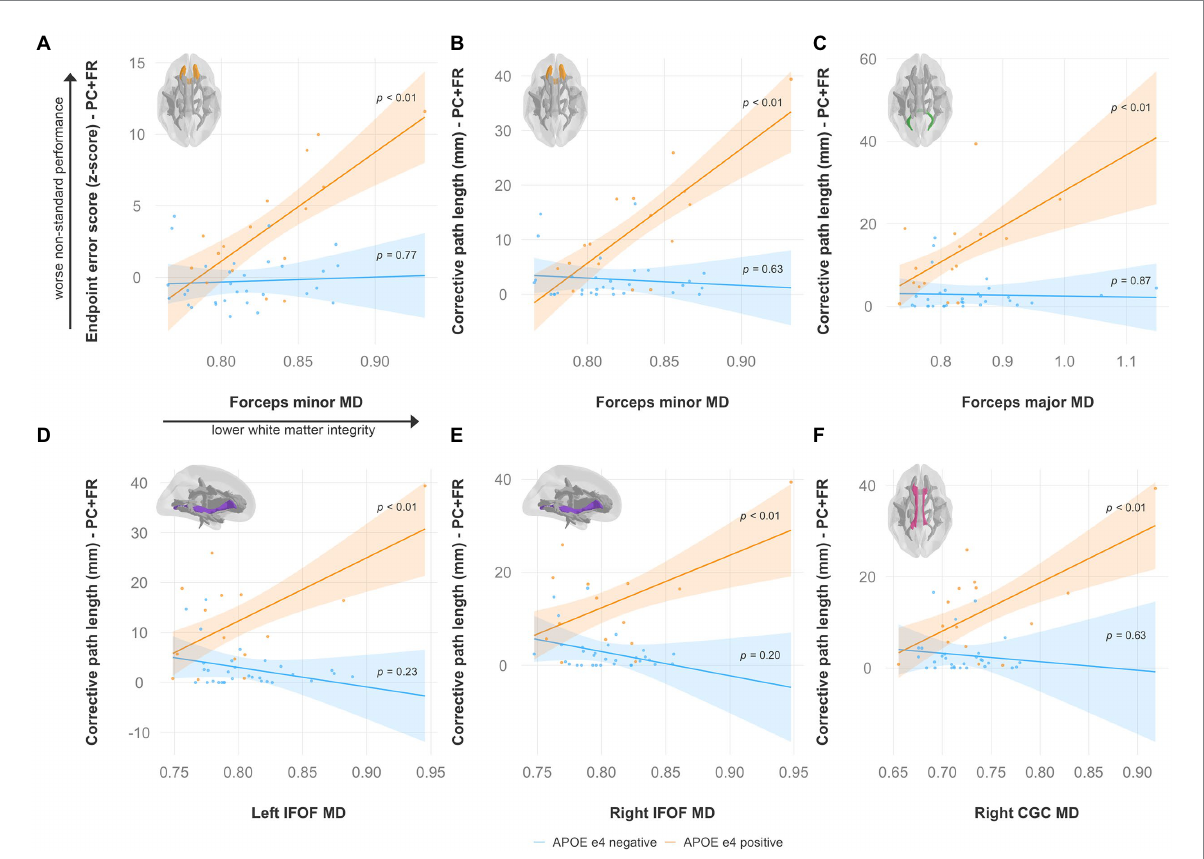
FIGURE 7 Higher mean diffusivity predicts worse visuomotor performance (reflected by higher endpoint error scores or corrective path lengths) in the plane-change feedback reversal condition only in APOE e4 carriers in several major white matter tracts, including the (A,B) forceps minor, (C) forceps major, (D) left IFOF, (E) right IFOF, and (F) right CGC. Significant results shown from multiple regression and simple slopes analyses. Brain figures made with “ggseg” R package (Mowinckel and Vidal-Piñeiro, 2020). PC + FR, plane change feedback reversal condition; APOE, apolipoprotein E; MD, mean diffusivity; IFOF, inferior fronto-occipital fasciculus; CGC, cingulum